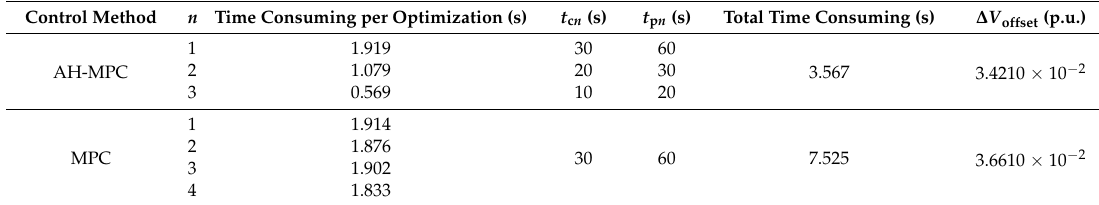
Table 5. Control performance comparison.